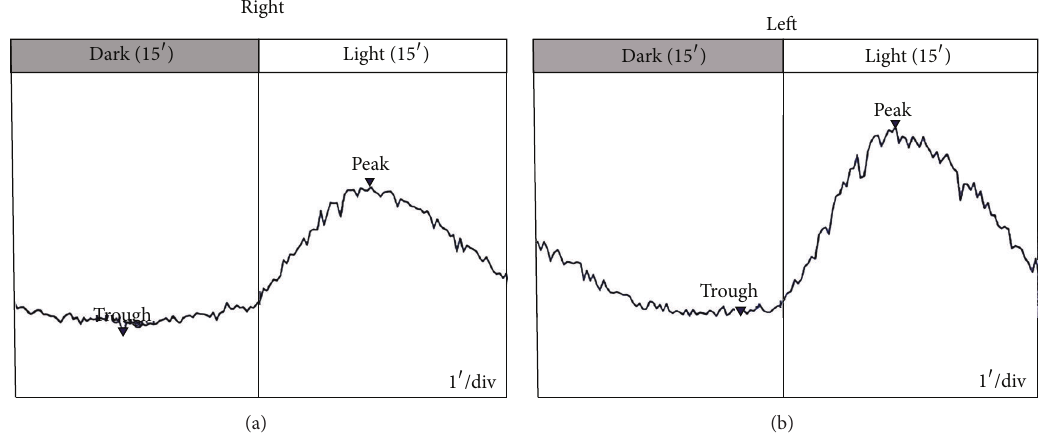
Figure 4: EOG recordings demonstrating a normal light rise and Arden ratio bilaterally.